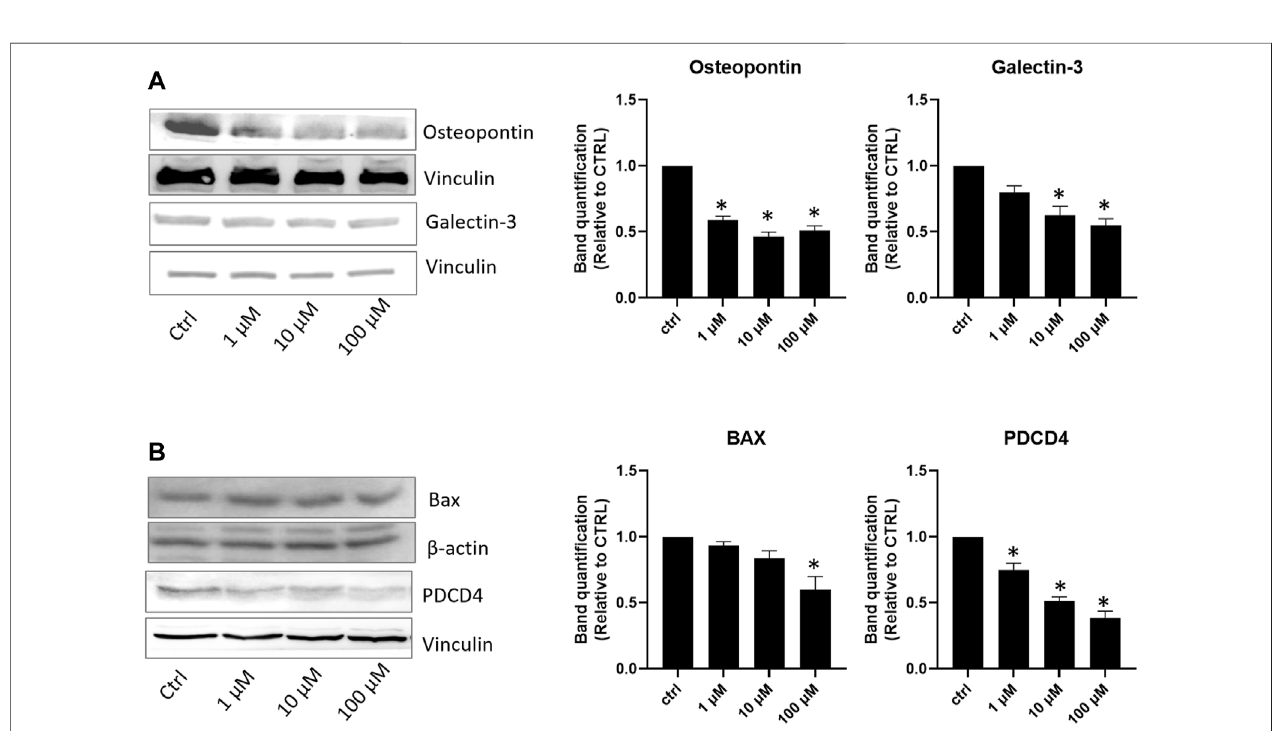
FIGURE2| Effectsoflisinopriltreatmentonproteinsinvolvedin fi brosisandapoptosis. (A,B) Westernblotanalysisofproteinsinvolvedin fi brosisandtheapoptosis mechanism. Data are mean ± standard errors. * p < 0.05 vs. CTRL.